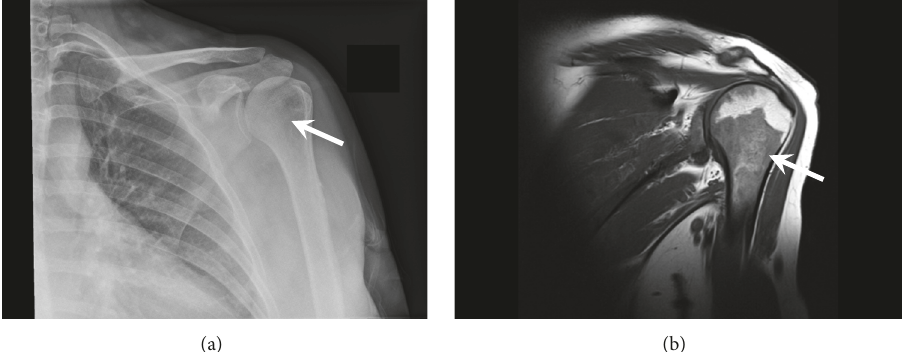
Figure 2: Imaging of left shoulder: (a) Plain radiograph showing lucency of humeral head. (b) MRI scan showing marrow infiltration of humeral head and